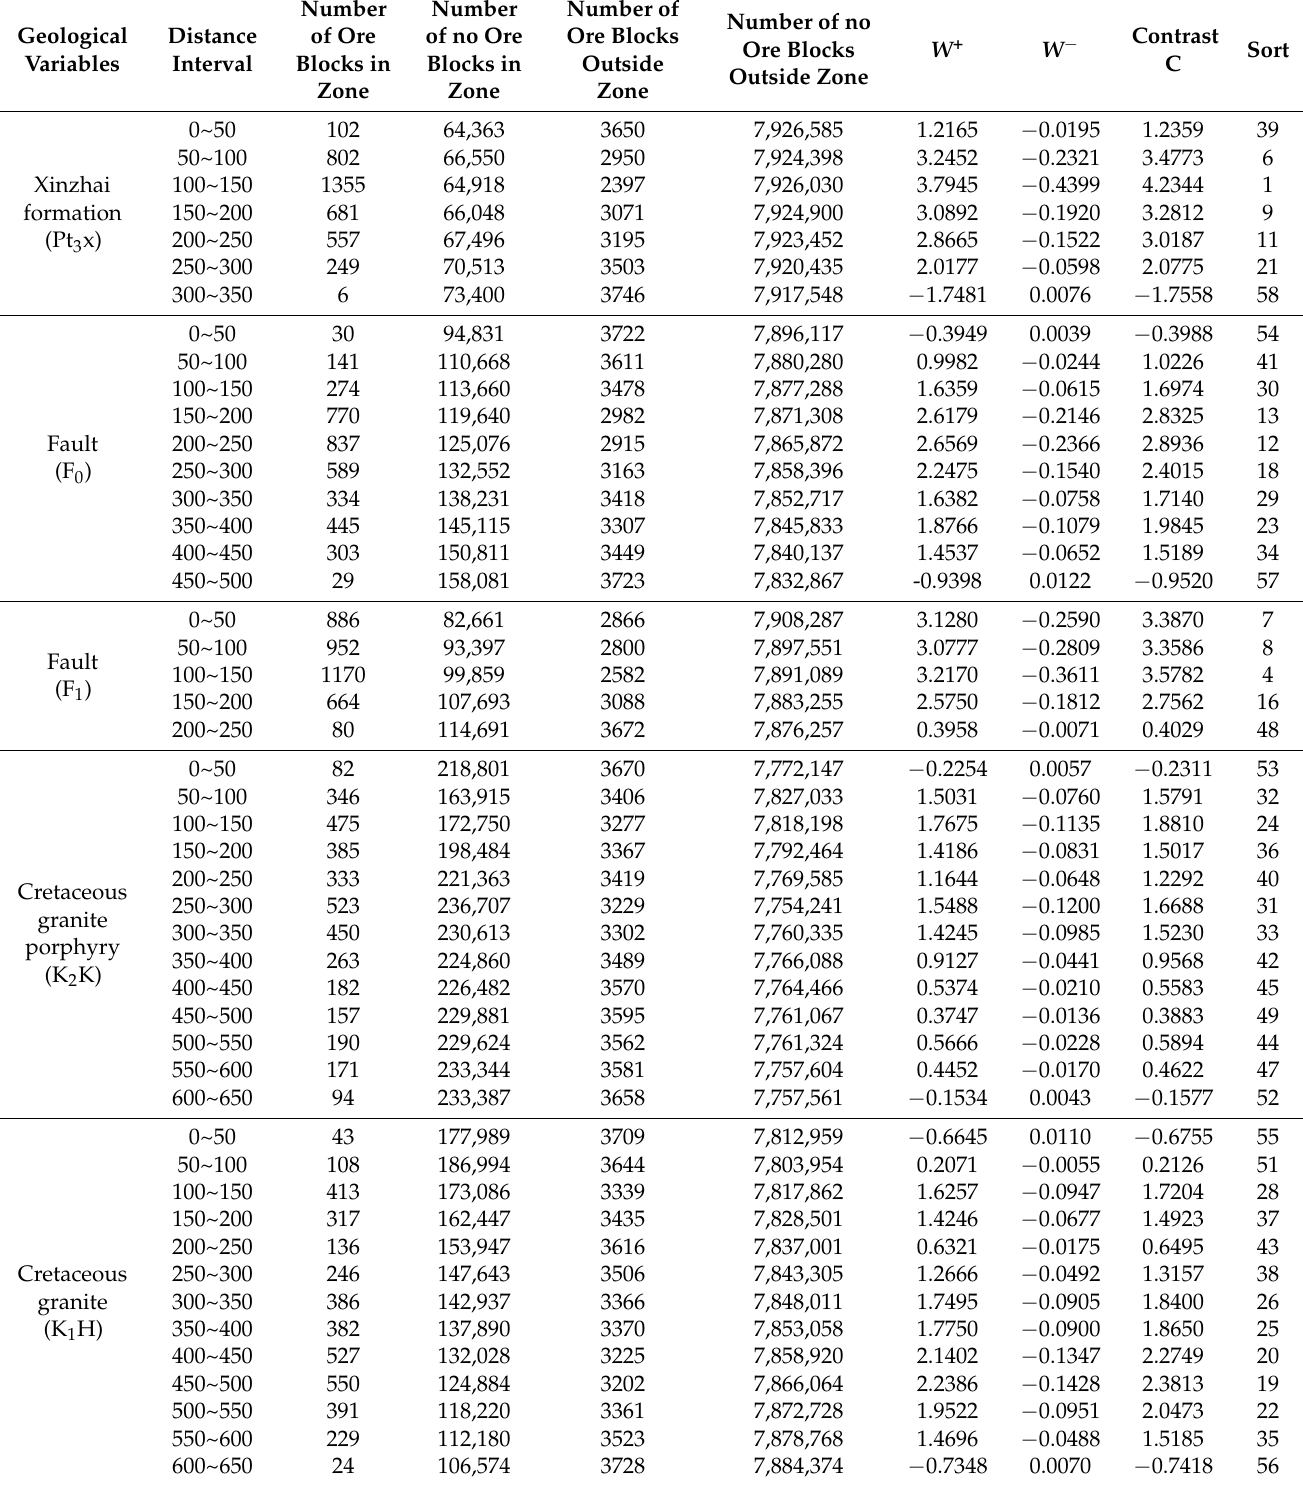
Table 1. Statistical table of geological variable weight